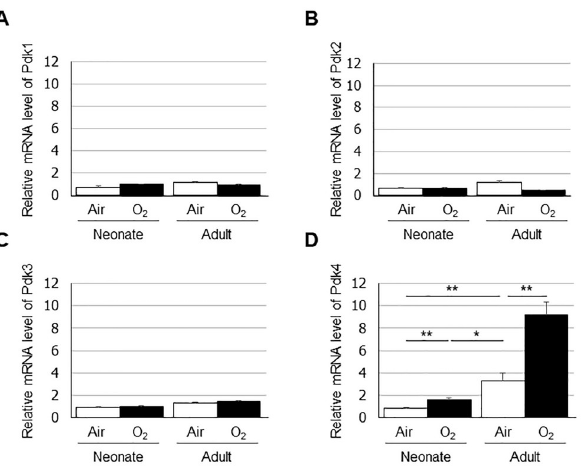
Fig 5. Expression levels of (A) Pdk1 , (B) Pdk2 , (C) Pdk3 , and (D) Pdk4 in the lungs quantified by real-time PCR. Data are shown as means ± SEM. Comparisons between groups were performed using a t test. � p < 0.05; �� p < 0.01. Air: normoxia; O2: hyperoxia; SEM: Standard error of the mean.